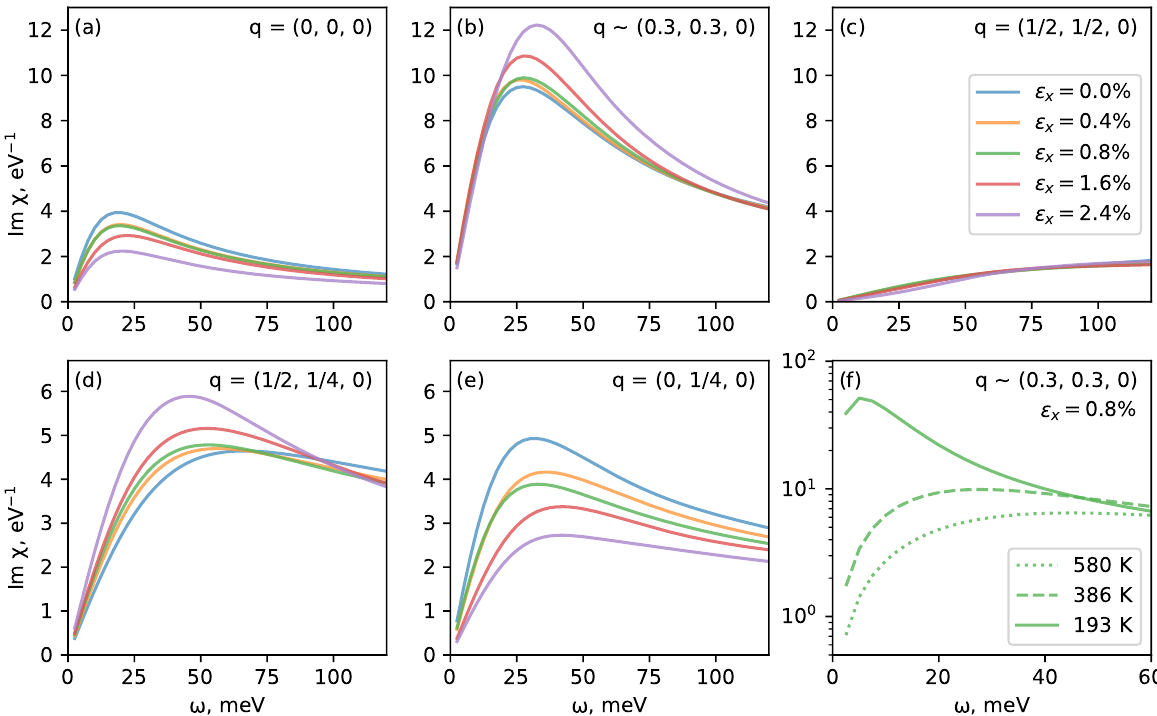
Figure 4. Strain and temperature dependence of susceptibilities: ( a – e ) Imaginary part of the dynamic spin susceptibility χ ( q , ω ) at some high symmetry points in the Brillouin zone for different strains (cid:101) x . The unstrained compound shows a spin fluctuation spectrum strongly peaked at ( 0.3,0.3,0 ) . With increasing strain, fluctuations become more strongly peaked at ( 0.3,0.3,0 ) , while they get suppressed at the ferromagnetic vector and remain fully gapped at the anti-ferromagnetic vector. ( d ) We also observe an increment in spin susceptibility at a vector ( 0.5,0.25,0 ) under strain. ( f ) With lowering temperature, the IC peak at q = ( 0.3,0.3,0 ) starts to diverge for strains (cid:101) x > 0.6%, signalling an instability towards a spin density wave